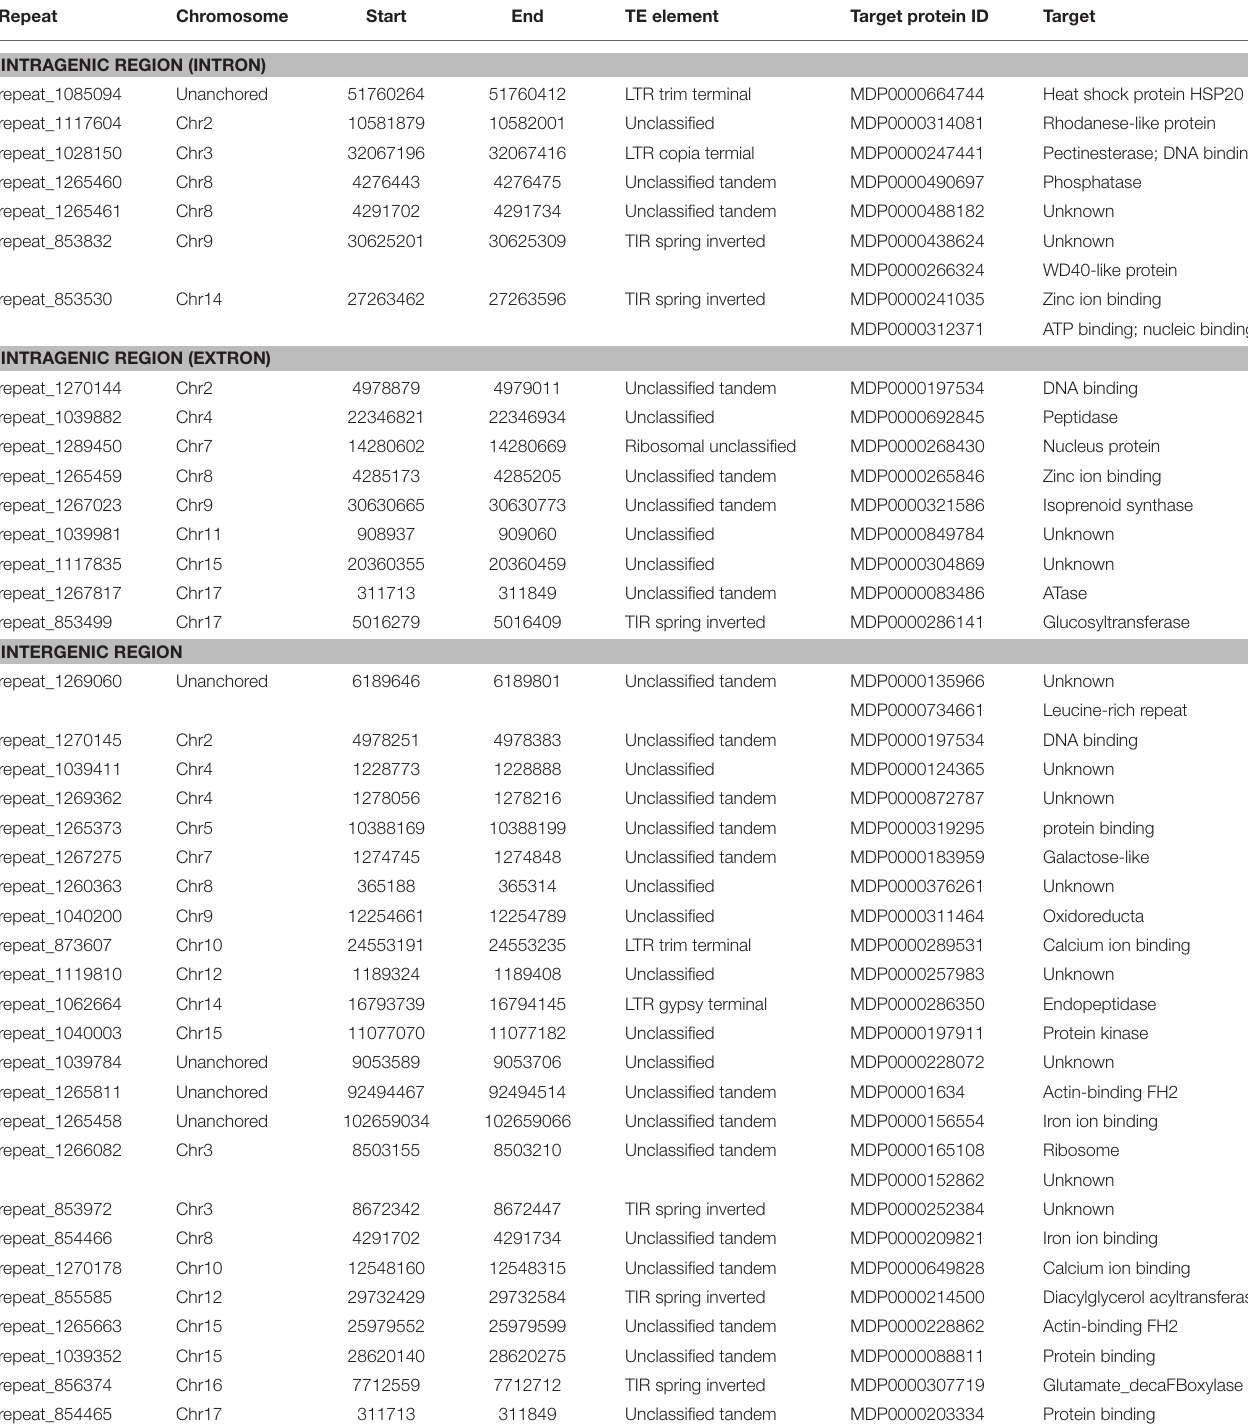
TABLE 4 | Potential targets and TE elements of top 40 differentially expressed siRNAs during the floral transition of Malus domestica .